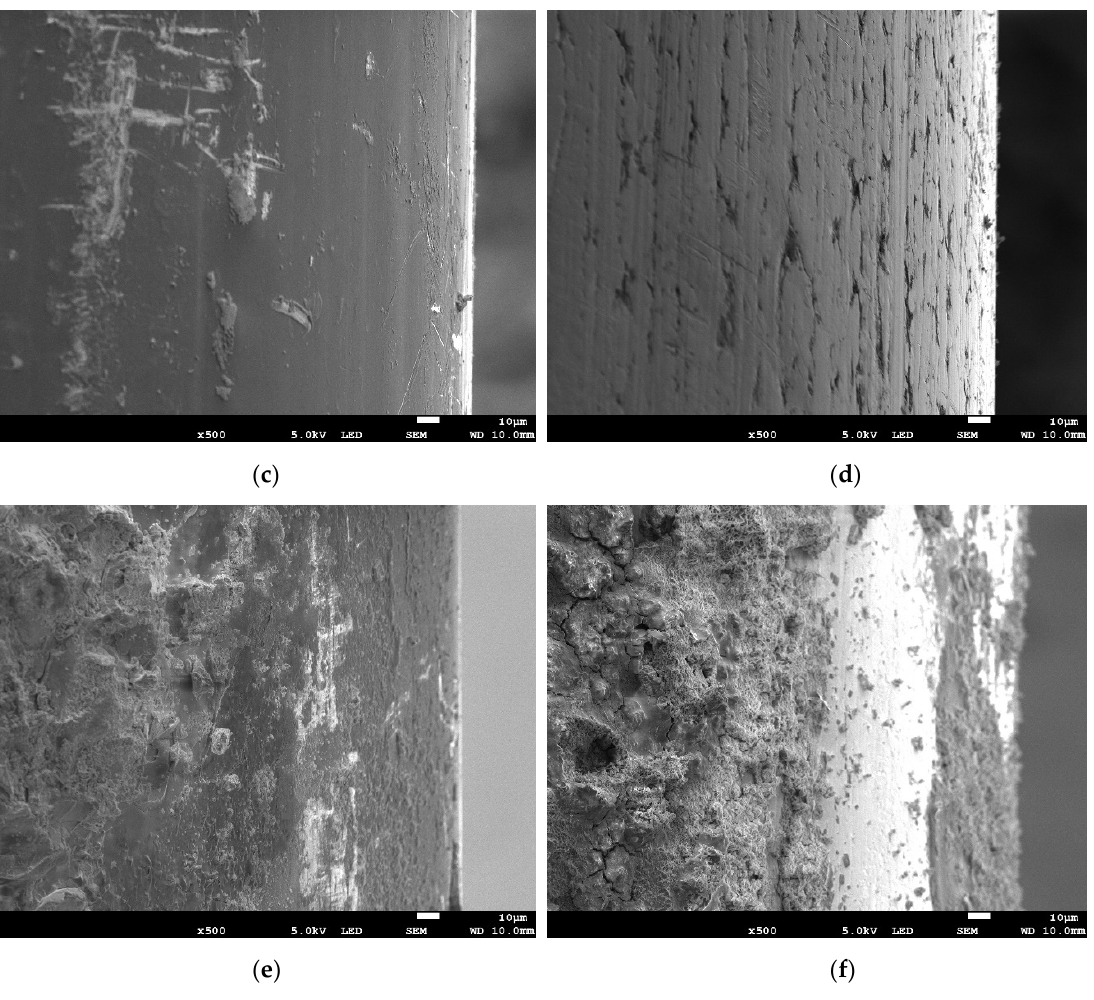
Figure 5. Surfaces of flux-cored wires: ( a ) A wire in delivery condition; ( b ) B wire in delivery condition; ( c ) A wire stored in GWS; ( d ) B wire stored in GWS; ( e ) A wire stored in MAB; ( f ) B wire stored in MAB.